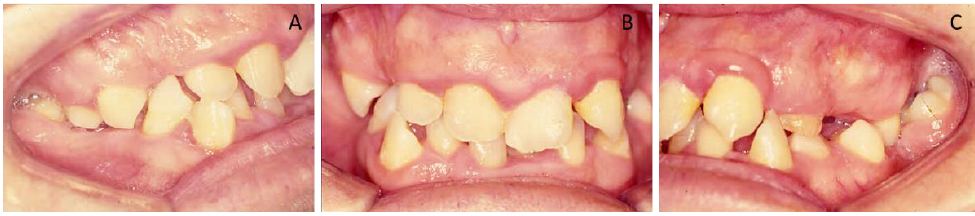
Figure 2. Pre-treatment, intra-oral photographs of patient showing right ( A ), frontal ( B ), and left occlusion ( C ). Note the missing teeth, gummy smile, and severe malocclusion. The first upper left molar, upper right canine, upper left lateral incisor, first upper left premolar, first upper right molar, first lower right molar, and first lower left molar are absent (Figure 3).